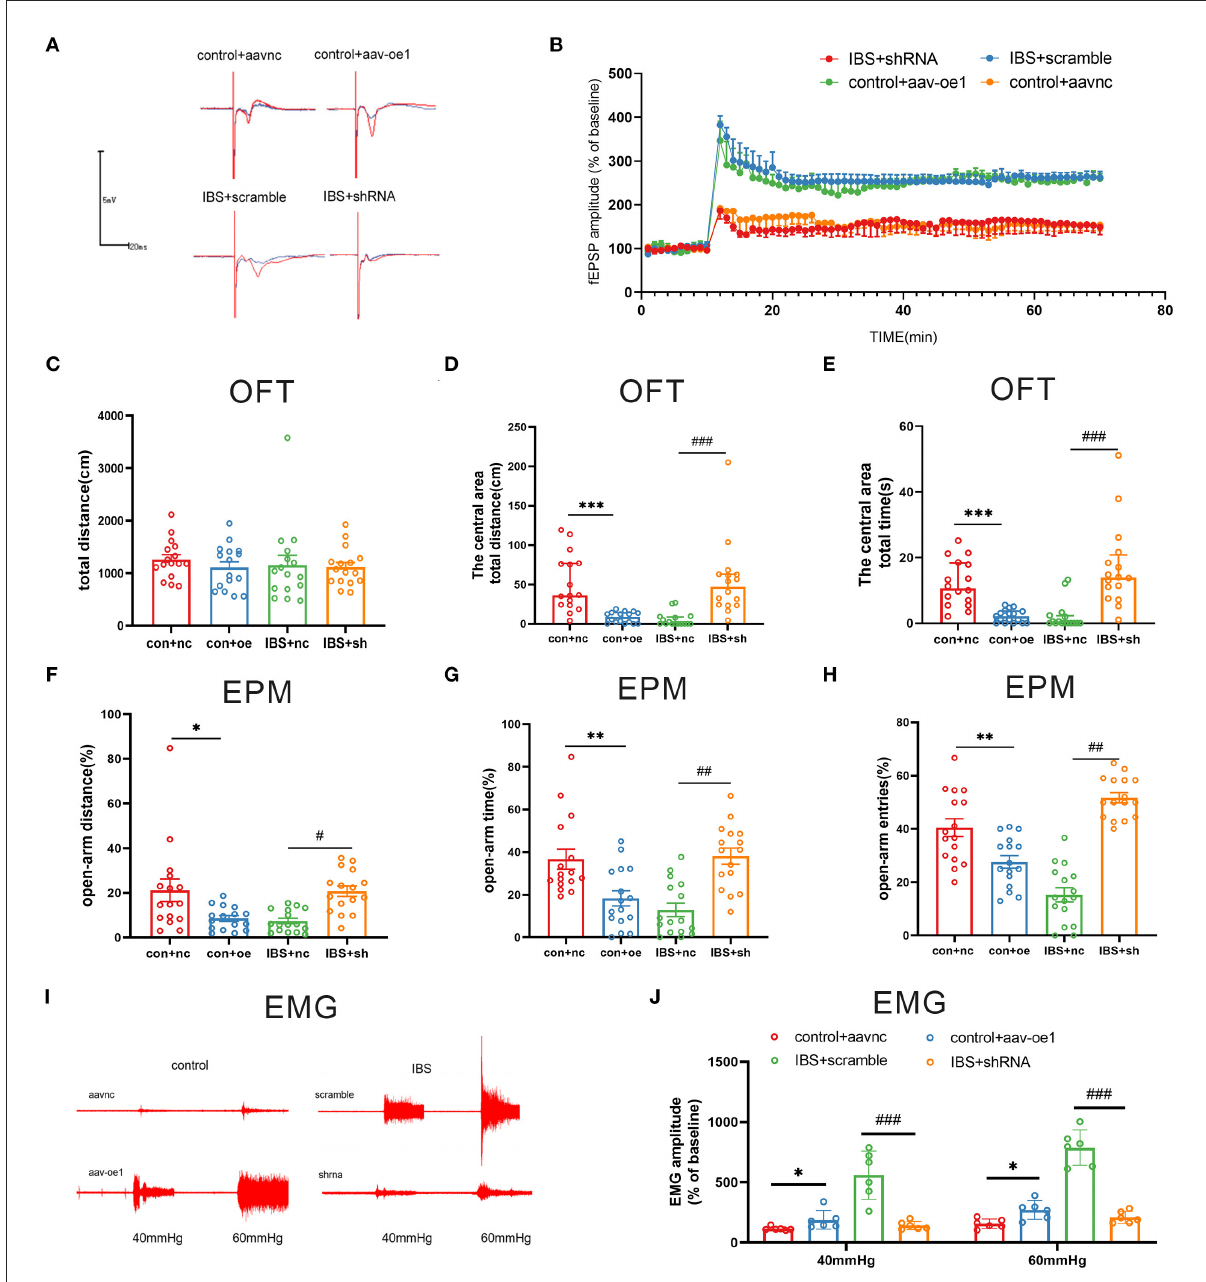
FIGURE3 CA1 shcirckcnk9 attenuates LTP, anxiety and visceral hypersensitivity in IBS-like rats while overexpression of CA1 circKcnk9 induces LTP, anxiety and visceral hypersensitivity in controls. (A,B) Sample waveforms and summary bar charts of field potential before and 60min after HFS in the slices of hippocampus. N = 3, * p < 0.05. Statistical analysis of the total distance (C) , the distance (D) and time (E) in the central area of the OFT. N = 16, *** p < 0.001, ### p < 0.001. Statistical analysis of the distance (F) , the time (G) , and the number of entries (H) in the open arm of EPM. N = 16, * p < 0.05, ** p < 0.01, # p < 0.05, ## p < 0.01. (I) The original typical recordings of EMG at 40 and 60 mmHg CRD. (J) The statistical chart of the percentage of EMG amplitude over baseline. N = 6, * P < 0.05, ### p < 0.001. CRD, colorectal distension; EMG, electromyography; EPM, elevated plus maze test; HFS, high-frequency stimulation; IBS, irritable bowel syndrome; LTP, long-term potentiation; OFT, open field